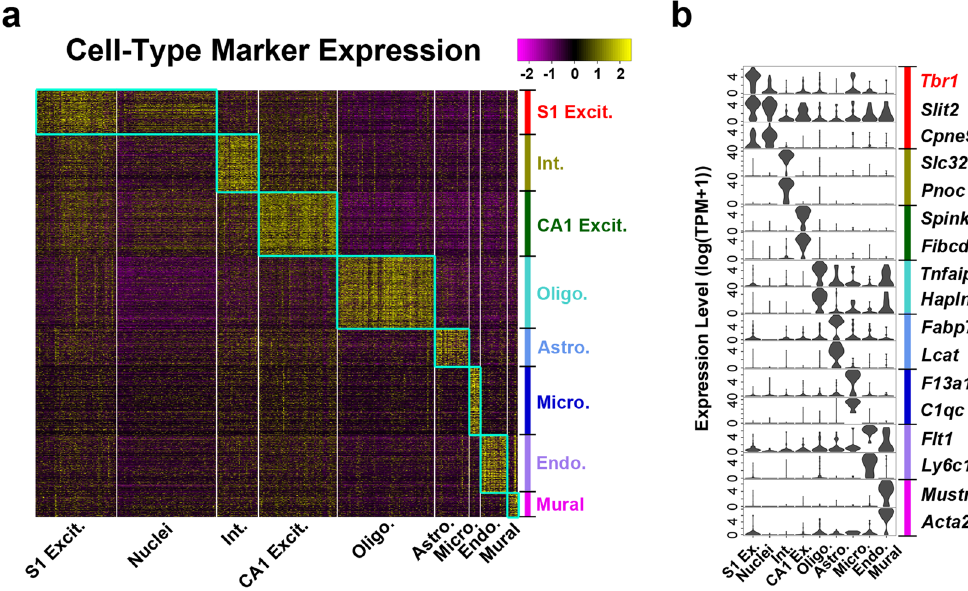
Figure 2. Nuclear transcriptomes accurately predict cell type. ( a ) Expression heatmap for cell type marker gene sets (colored bar) across all nuclear and cellular clusters (Fig. 1e). ( b ) Violin plots showing expression of select cell type marker genes across